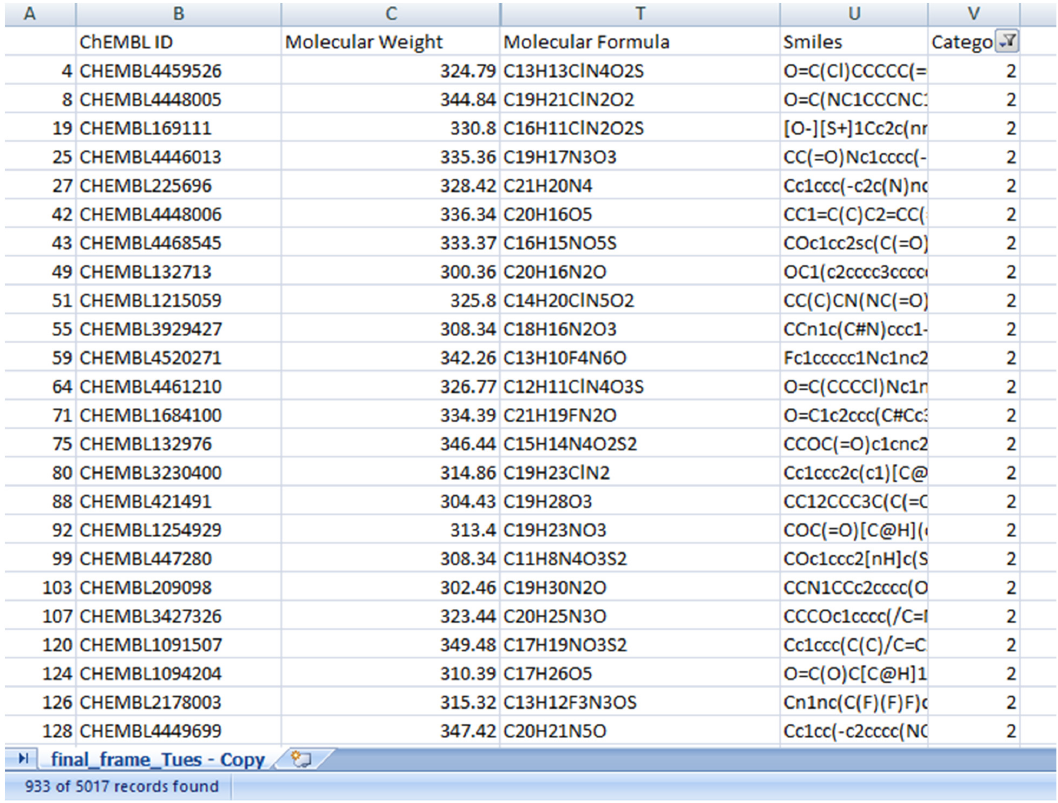
Figure 2 . Similar property compounds in cluster 2.